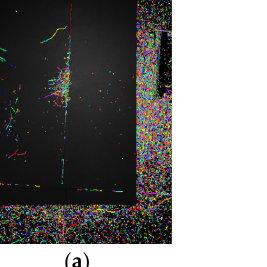
Figure 9. The crack detection result of image 2 by the algorithm in this paper ( a ) image 2; ( b ) gray projection curve of image 2; ( c ) DPG detection result; ( d ) crack extraction results; ( e ) manual annotation.